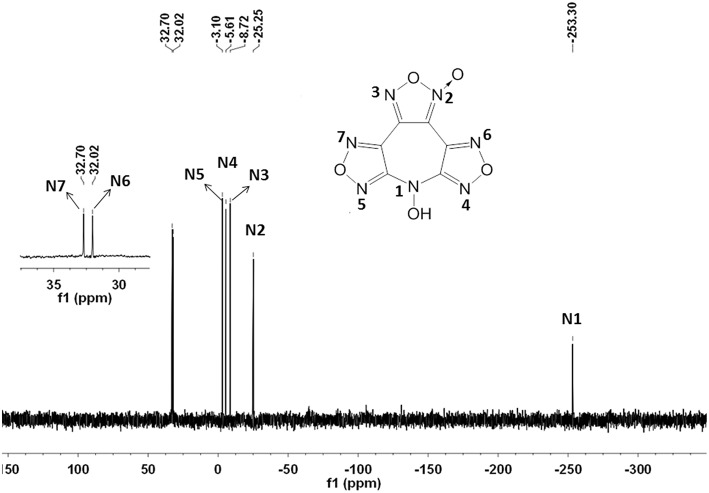
15N spectrum of compound 4 in [D6]DMSO.